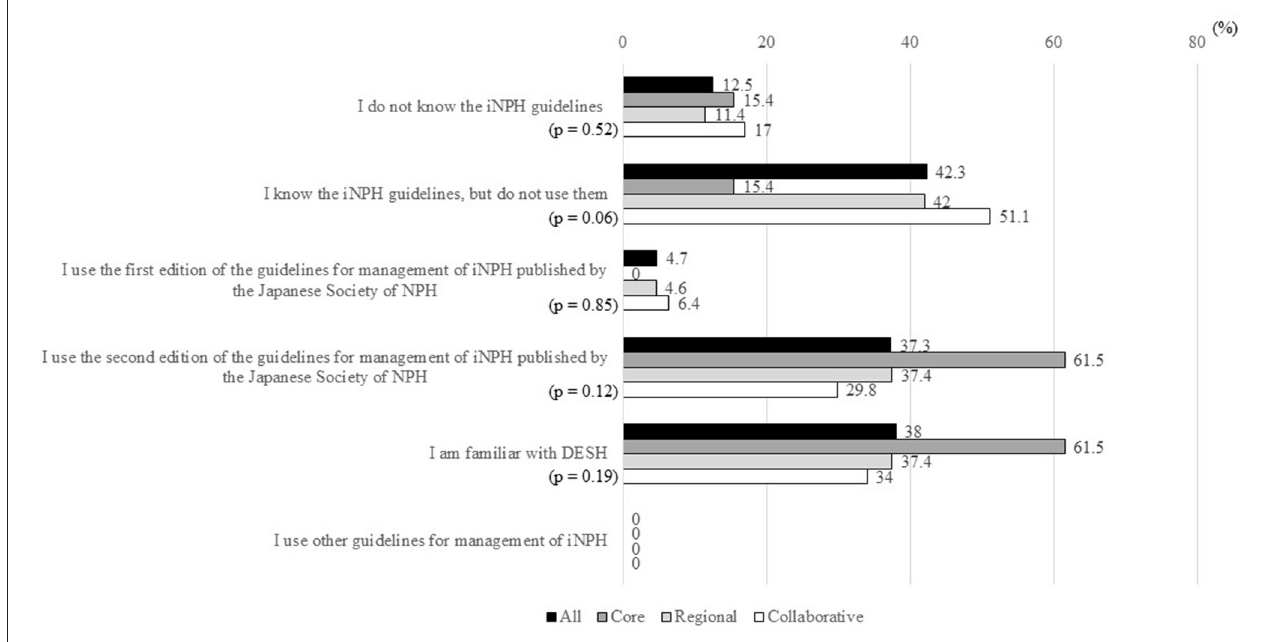
FIGURE 4 | Percentages of MCDs that answered “Yes” to items in response to the question “Do you know and use the guidelines for the management of iNPH?”. MCD, medical center for dementia; iNPH, idiopathic normal-pressure hydrocephalus; NPH, normal-pressure hydrocephalus; DESH, disproportionately enlarged subarachnoid space hydrocephalus. *The ratio of “Yes” answers were compared between the three types of MCDs using Fisher’s exact test.